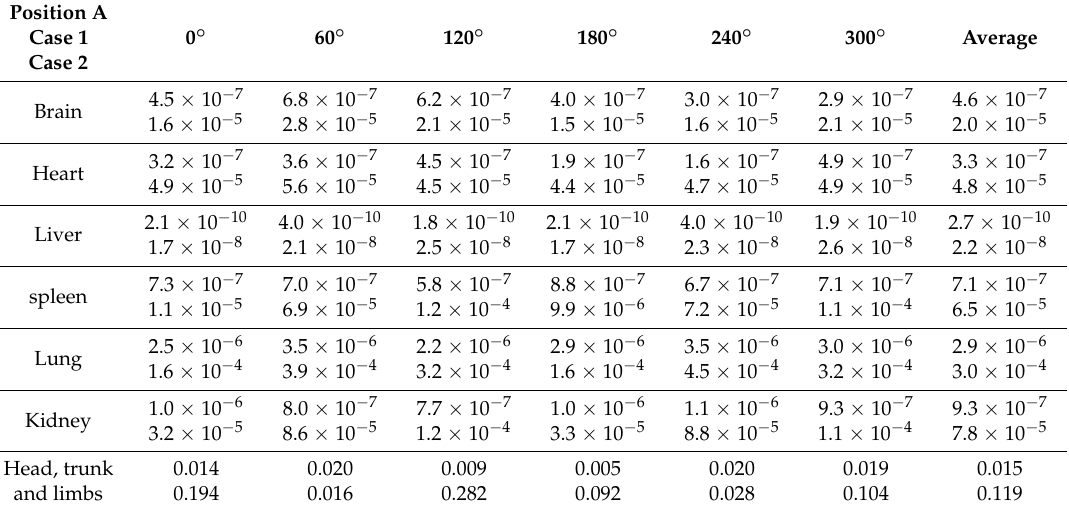
Table 4. The peak spatial-average specific absorption rate (SAR) values (W/kg) in typical tissues with different orientations in position A.